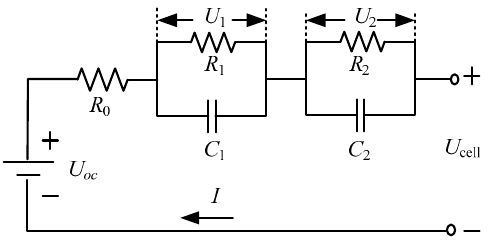
Figure 1. Equivalent circuit model of the single-flow zinc–nickel battery.